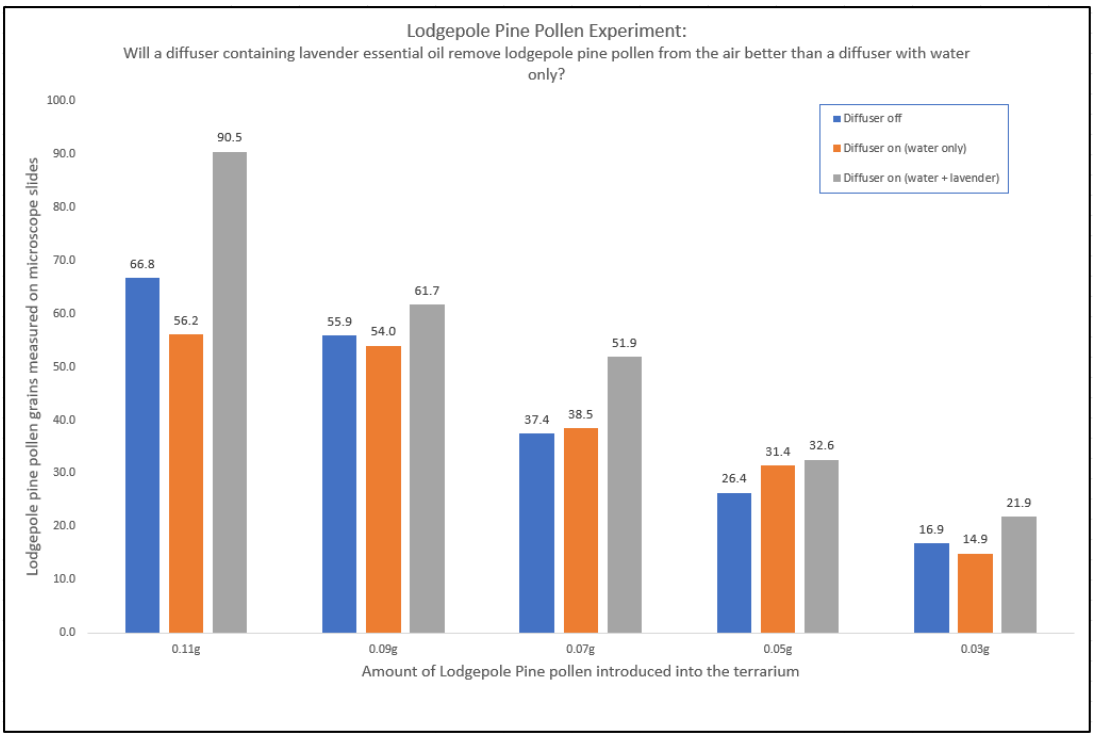
Figure 7. The amount of lodgepole pine pollen found on the microscope slides in an environment with diffuser off (blue), with diffuser on (water only) (orange), and with a diffuser containing 10 drops of lavender essential oil (grey). Note: Each data point on the graph is the average pollen count of 27 data points.